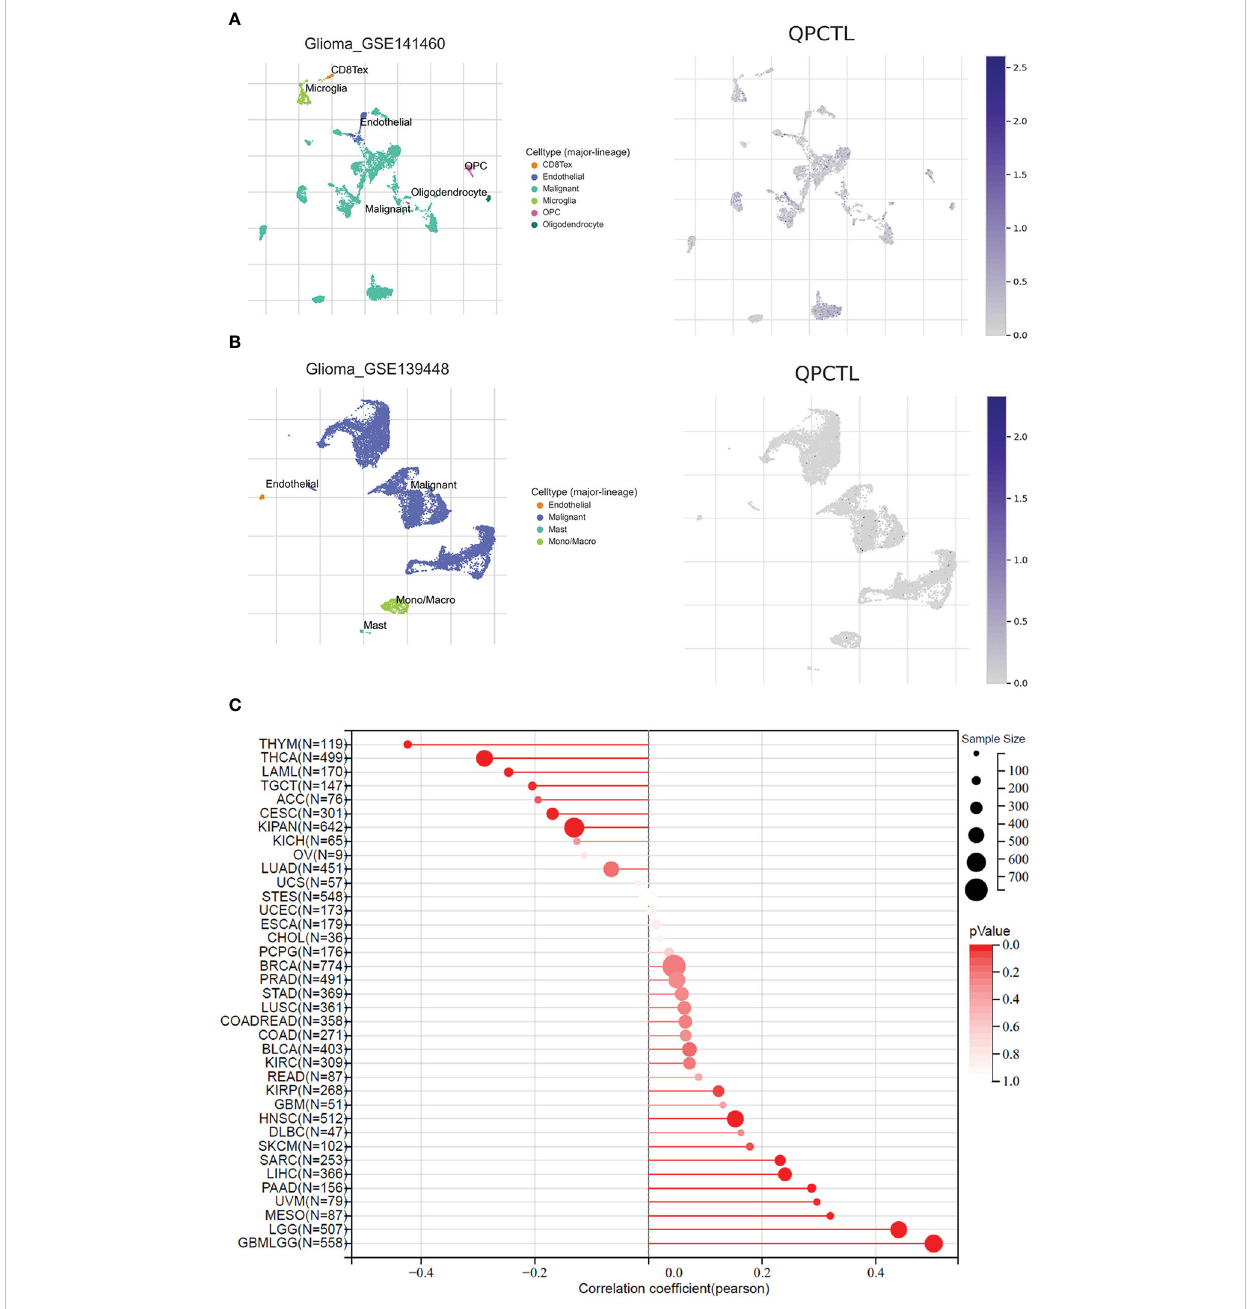
FIGURE 7 QPCTL is essential for glioma cell proliferation and positively correlated with glioma stemness. (A) The expression of QPCTL in GSE 141460, data from GEO single-cell sequencing. (B) The expression of QPCTL in GSE 139448, data from GEO single-cell sequencing. (C) The correlation between the expression of QPCTL and the cancer stemness, data from